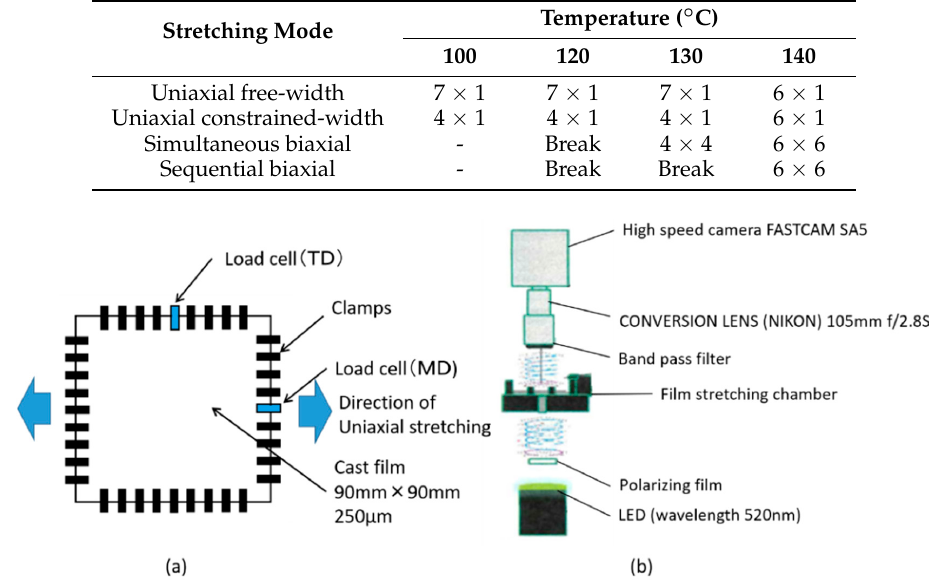
Figure 2. Schematic diagram of ( a ) film stretcher and ( b ) high-speed camera used for real time retardation measurements.